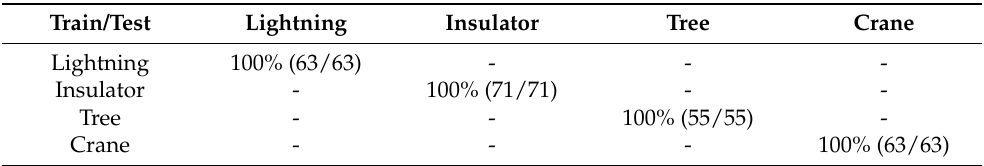
Table 8. Accuracy of the created decision tree w.r.t. all splits predictor selection on test set data for 70% training and 30% testing.